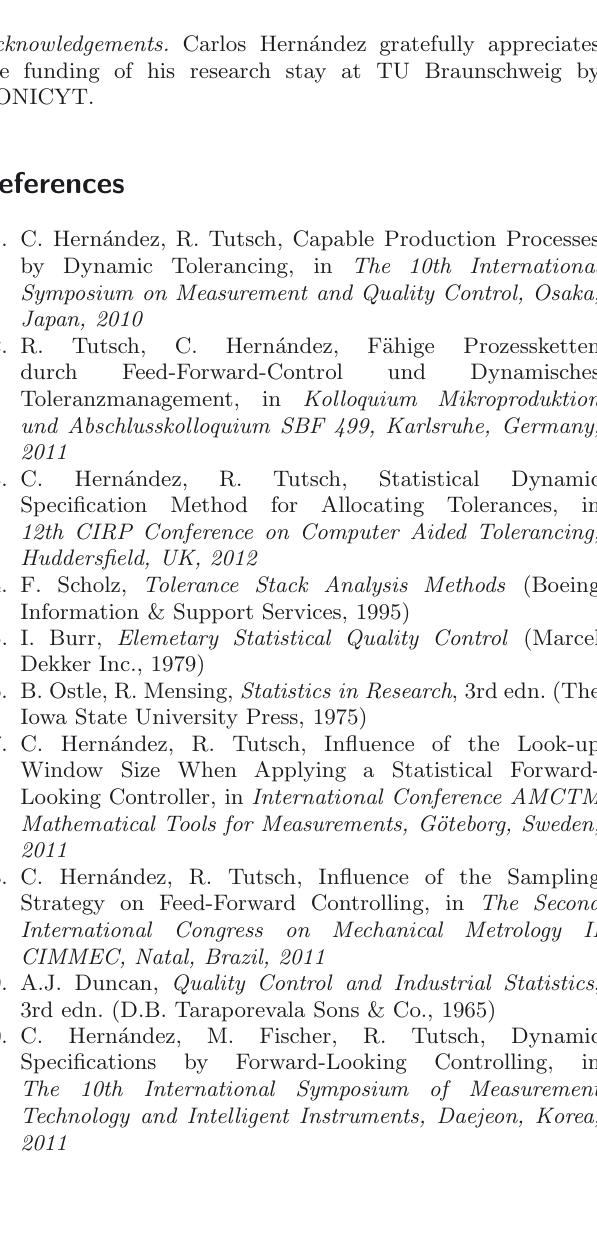
Fig. 5. Sample mean (dark line) v/s cumulative de-noised average (white